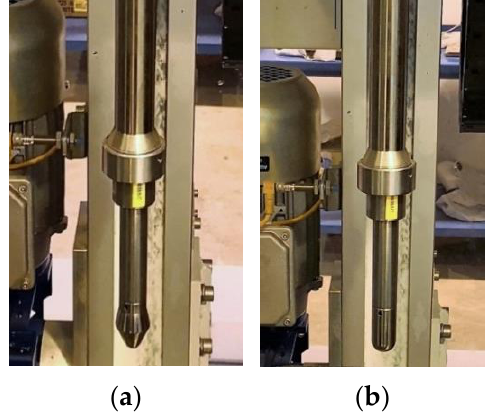
Figure 2. Conical ( a ) and hemispherical ( b ) impactor.